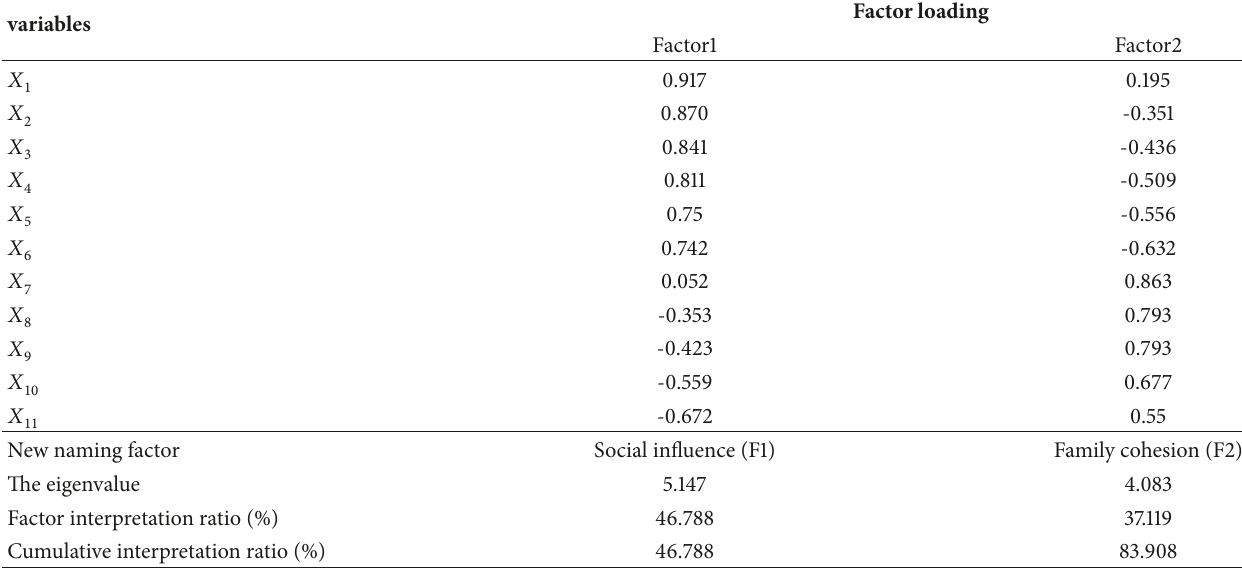
Table 4: Factor analysis results of